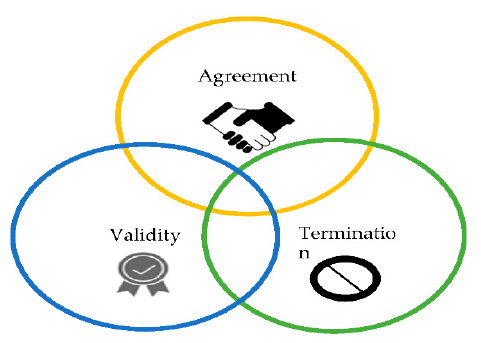
Figure 1. Consensus properties.